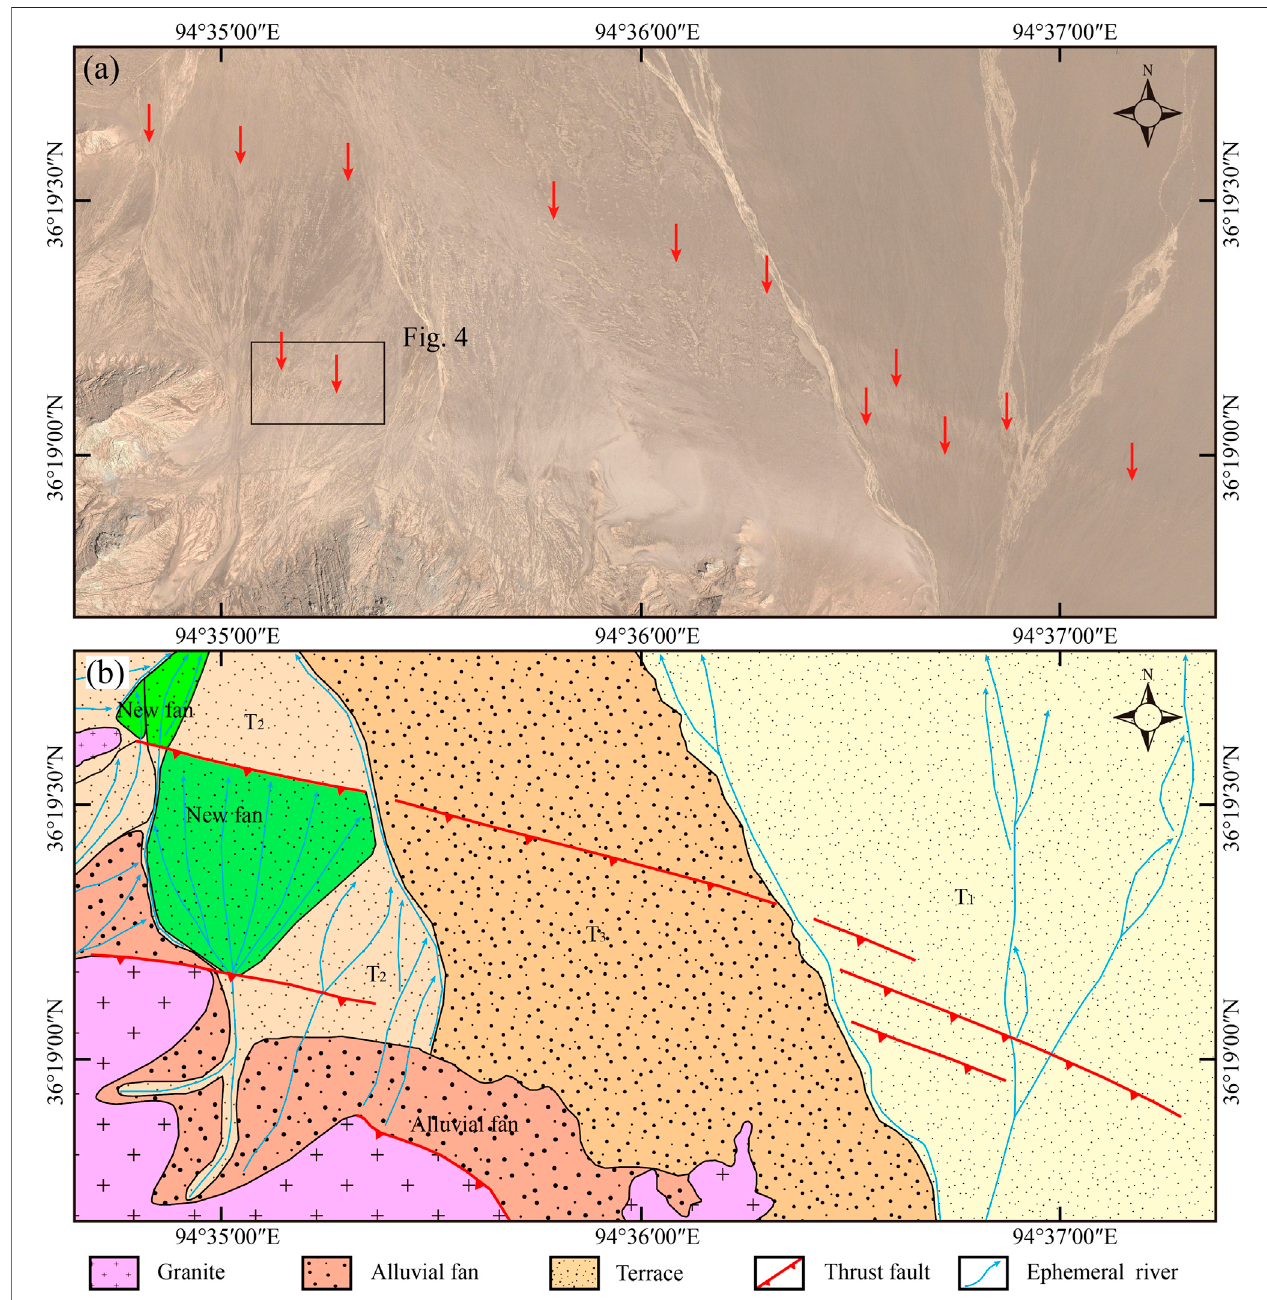
FIGURE3|(A) Image from Google Earthimage at theXinlechunsite. Redarrows indicate theactive fault traces.Theblackboxes indicate thelocation of Figure 4 . (B) Interpretation of the Terraces, alluvial fan and faults. Red bold lines represent the active fault